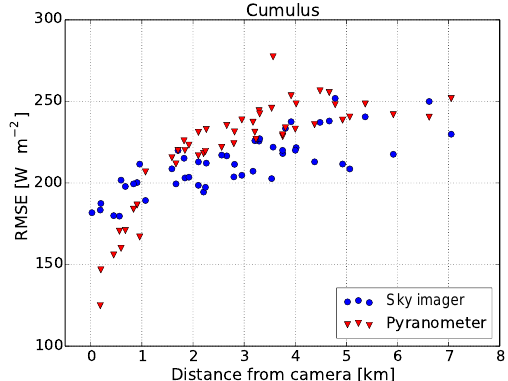
Figure 9. Root mean square error (RMSE) of sky imager analysis for each station and for cumulus cloud type (blue dots). The red triangles mark the RMSE of each station when compared to the station closest to the camera. This station has no error and therefore is not shown in this